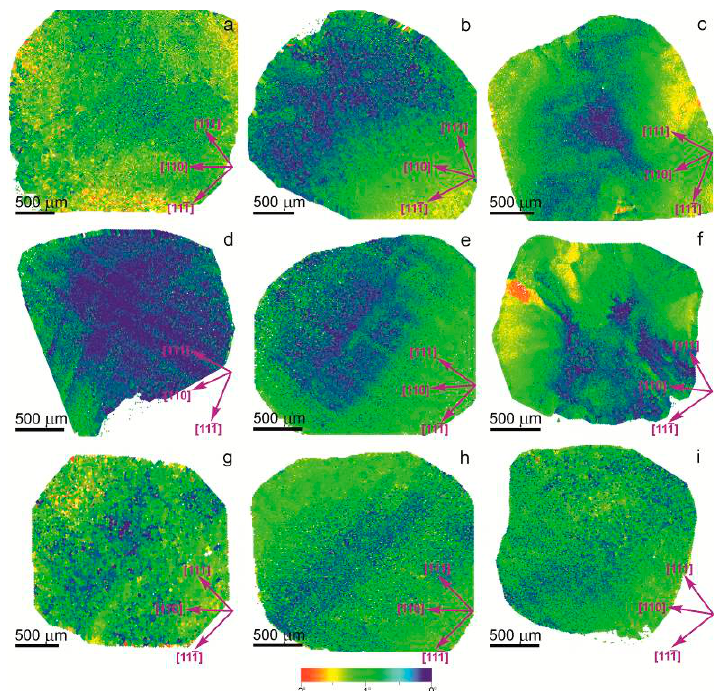
Figure 7. Misorientation patterns of yellow cuboid diamonds from the Northeastern Siberian platform. EBSD maps over a large parts of the polished plates showing a change in orientation up to 2° from blue to red ( a —MP-30; b —MP-43; c —MP-56; d —MP-60; e —MP-71; f —MP-83; g —MP-87; h —MP-98; i —MP-108).